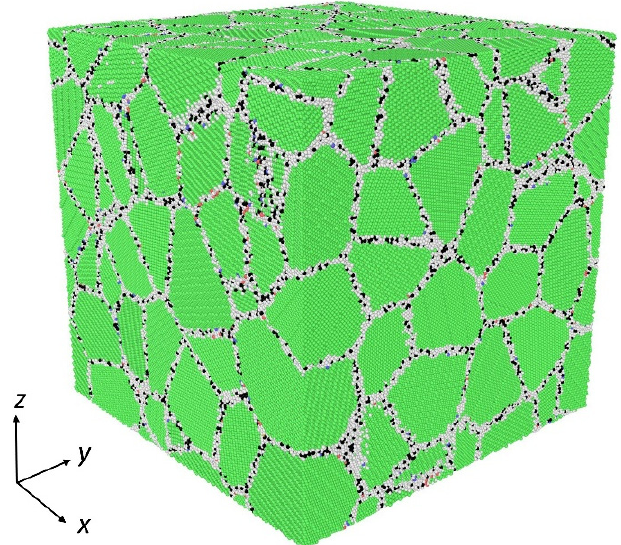
Figure 1. Atomic configuration of segregated polycrystalline Ni-Mo model with 𝑑 = 7.9 nm.